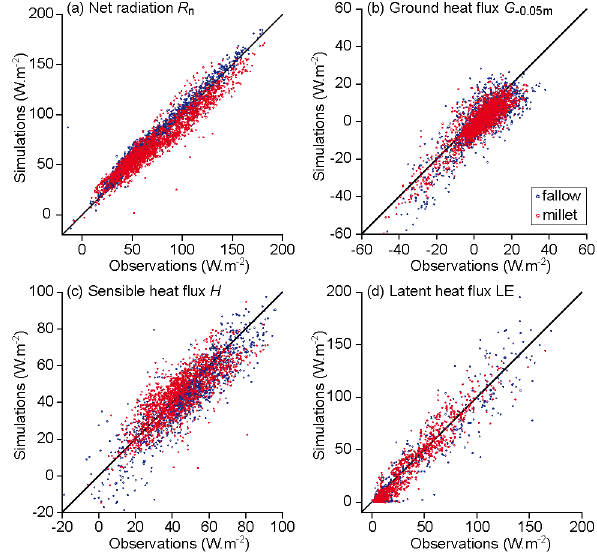
Figure B1. Simulated vs. field-estimated daily energy fluxes of (a) net radiation, (b) ground heat (at 5cm depth), (c) sensible heat, and (d) latent heat, for the fallow (blue) and millet (red) plots, over the 2005–2012 study period (only days with no missing data are